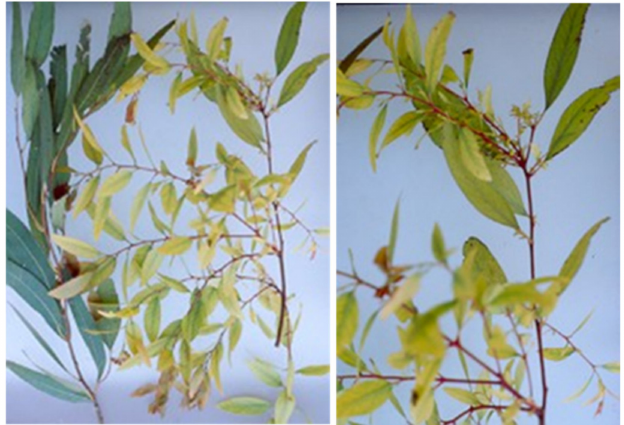
Figure 7. Small leaves, yellowing, and shortened internodes on eucalyptus ( Eucalyptus spp.) shoots affected by eucalyptus little-leaf. Healthy shoot on the left of the left